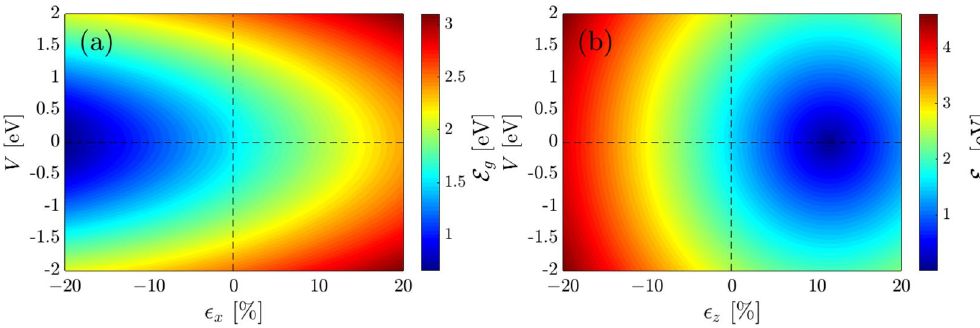
2 eV associated with 2 eV V ≤ ≤ + −